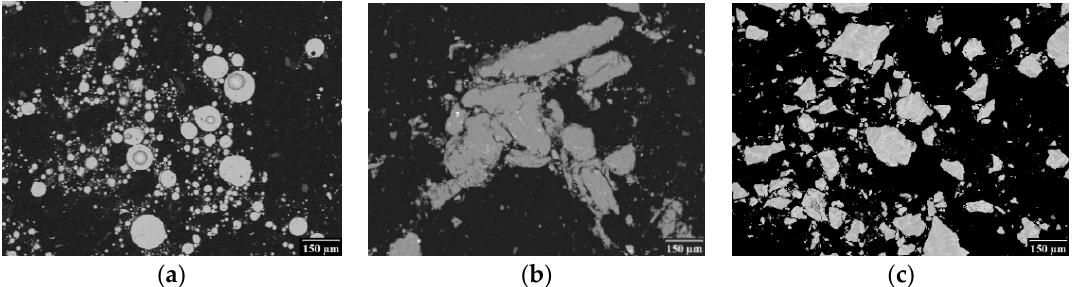
Figure 1. Microstructure of pre-alloyed powders (SEM BSE micrographs): ( a ) FeAl25, ( b ) AlSi30, ( c ) FeSi25.